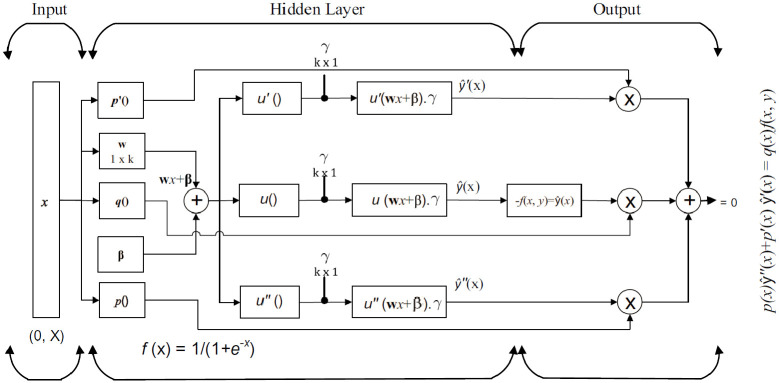
Neural network architecture.